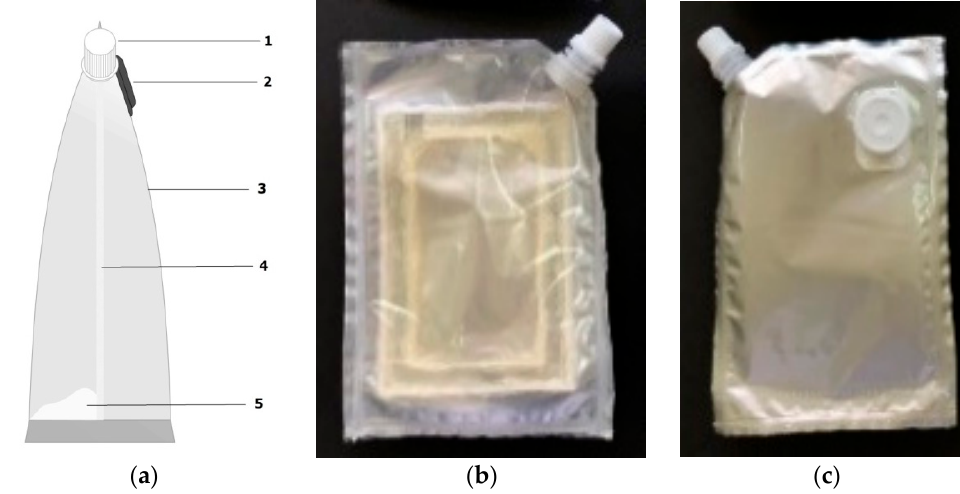
Figure 2. A drinking water bag made from a combination of aluminum foil and PP plastic with a chitosan / starch membrane filter inside. ( a ) Water bag design (1 = the lid on the front of the bag, 2 = the lid on the back of the bag, 3 = polypropylene plastic, 4 = chitosan-starch membrane, 5 = draw solution), with the photographs of ( b ) the front side and ( c ) backside of the bag.